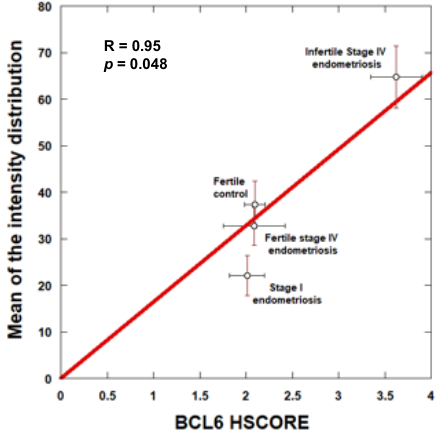
Figure 4. Correlation between computer-assisted image quantification and HSCORE analyses for endometrial BCL6 expression.